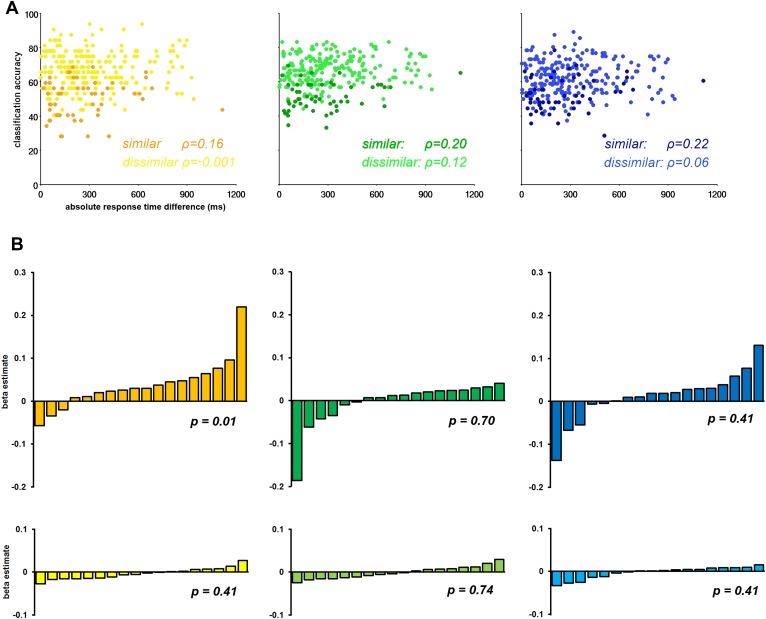
The influence of response time (RT) on classification accuracy.(A) Correlation between classification accuracy and RT difference in the three DMN sub-networks. Each point represents data for a single task pair in a single subject, with mean CA across ROIs of the named sub-network plotted against absolute RT difference. The darker shades in each graph are taken from the similar task pairs, while the lighter shades are taken from the dissimilar task pairs. (B) Beta estimates for the association of CA and RT in each subject for similar and dissimilar task pairs of the three DMN sub-networks. In each graph subjects' beta estimates are sorted is in ascending order. Top row, a–c, displays beta estimates for similar task pairs in the Core, MTL and DMPFC, respectively. Bottom row, d–f, shows beta estimates for dissimilar task pairs in the Core, MTL and DMPFC, respectively. The p-value from a 2-tailed, 1-way t-test of each graph's beta values is shown.